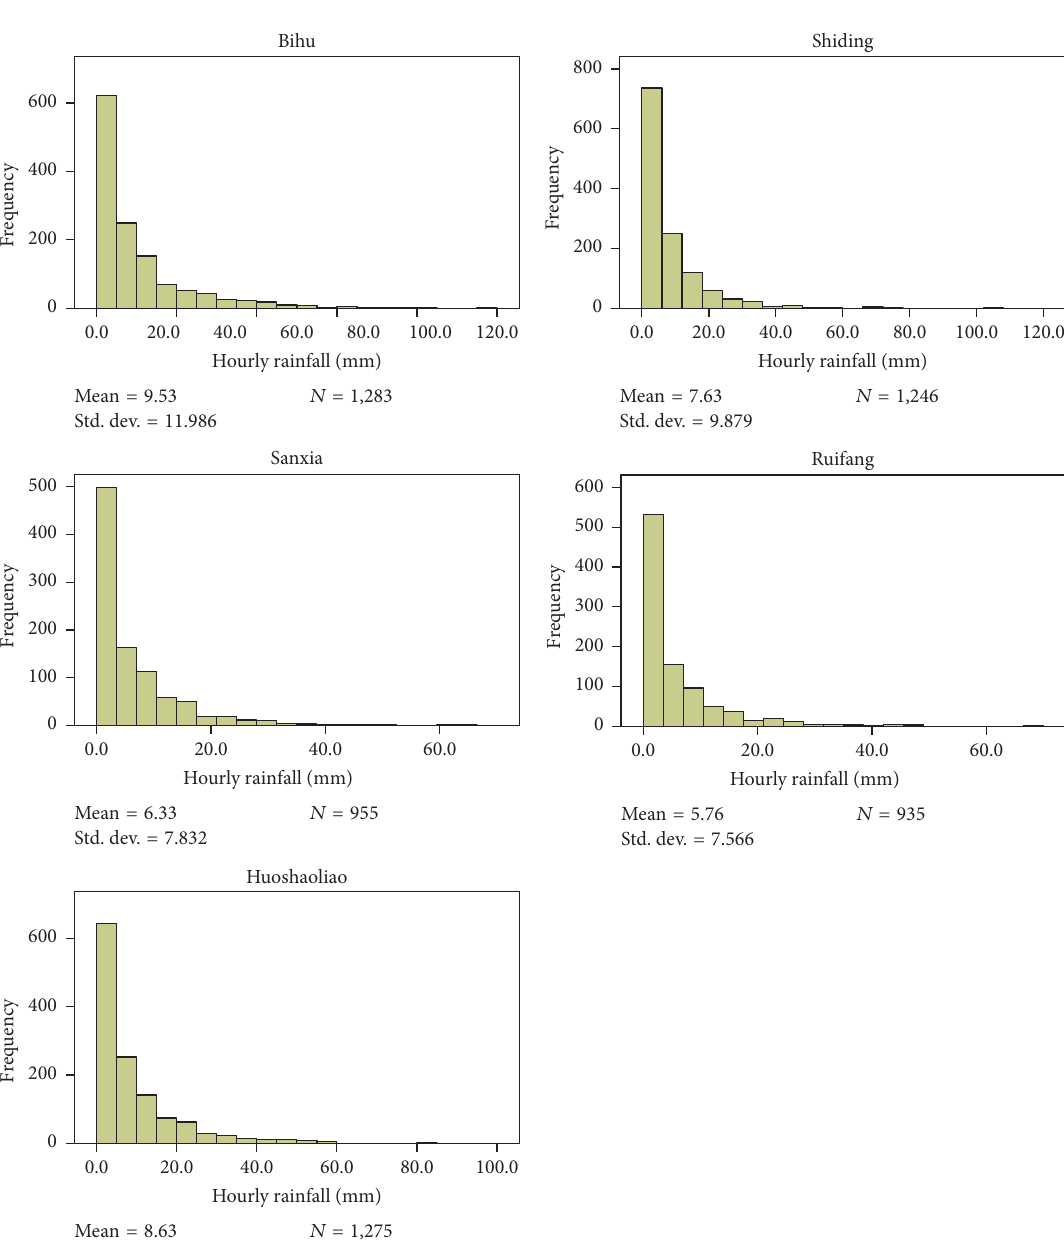
study. Each of them caused intense rainfall in Tamsui